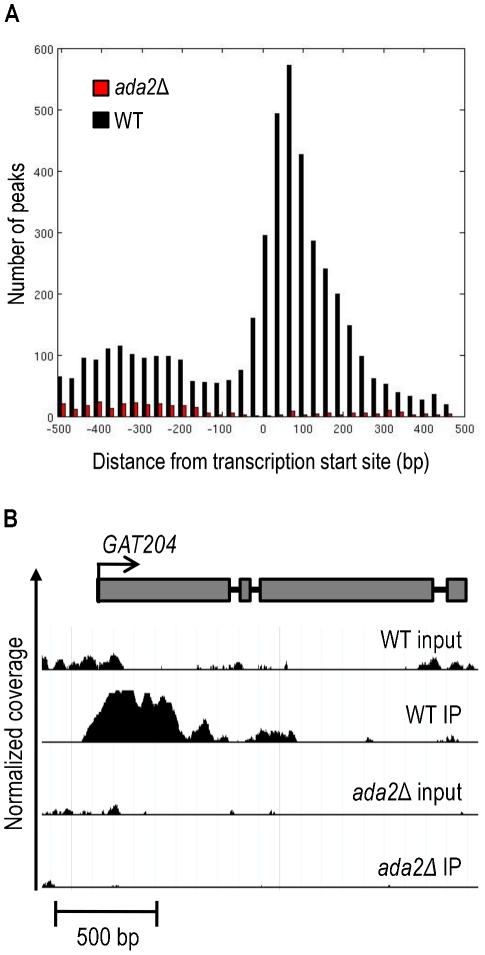
Ada2-dependent acetylation of H3K9 is enriched near gene transcription start sites.ChIP-Seq was performed on wild type (WT) and the ada2Δ mutant to identify genes located in the proximity of acetylated H3K9. Panel A, a histogram of peaks that occur within 500 bp of the transcription start site of all identified genes [45]. Panel B, an example of ChIP-Seq data aligned to a gene model of GAT204, which was identified as Ada2-dependent by both ChIP-Seq and RNA-Seq. The y-axis represents normalized coverage (reads per million mapped) for samples defined in the text. Coverage is shown for 2 standard deviations above the mean input sample coverage and above. Note that the input DNA profiles are similar for WT and mutant cells, while specific H3K9 associated sequences show TSS-associated peaks only in the WT.